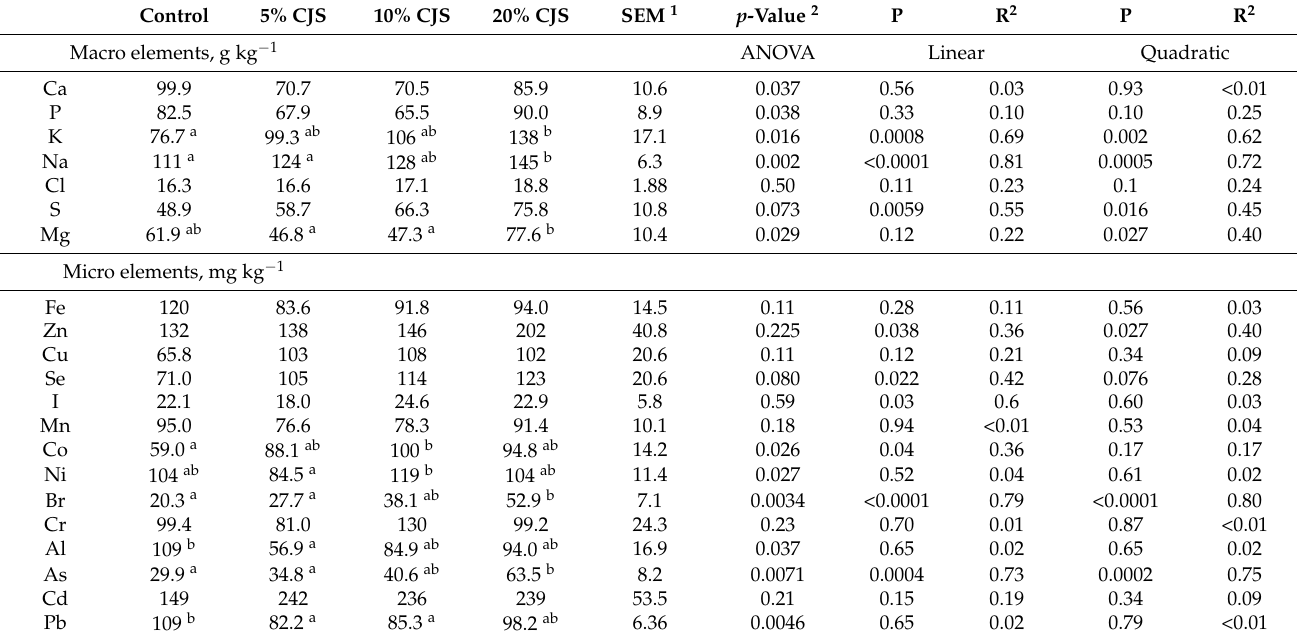
Table 5. Fecal excretion (% of ingested) of macro and micro minerals from Atlantic salmon ( Salmo salar ) in the retention experiment where salmon were fed increasing levels of Cyberlindnera jadinii (CJS).